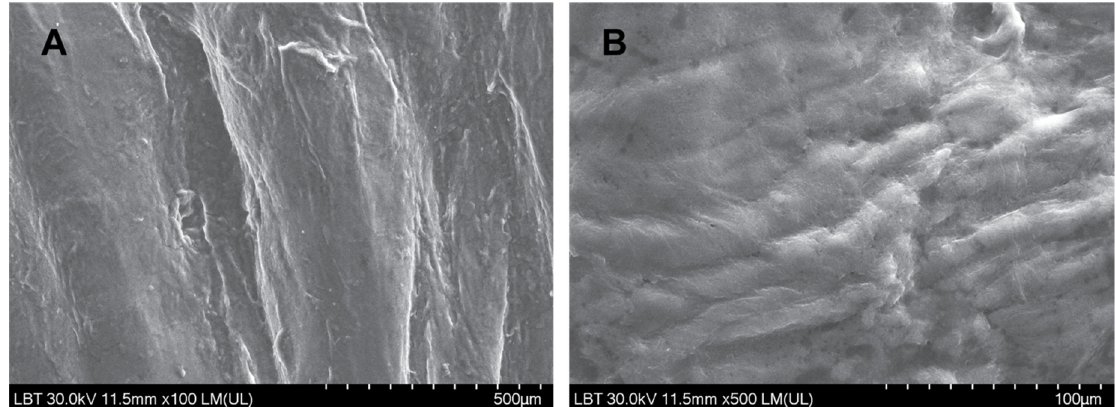
Figure 1. ( A , B )—Ultramicroscopic aspects of the middle ear mucosa in deceased COVID-19 patients (SEM): flat epithelial surface, without microbial presence or surface immune cells.